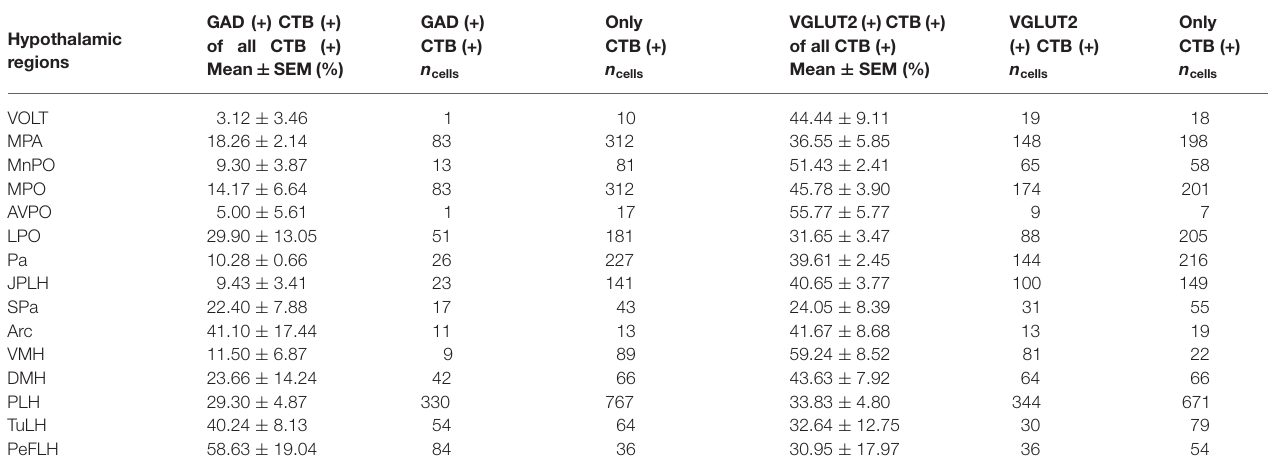
TABLE 3 | Colocalization percentages of GAD65 or VGLUT mRNA signals in VTA-projecting CTB-IR neurons in various hypothalamic areas. Hypothalamic regions